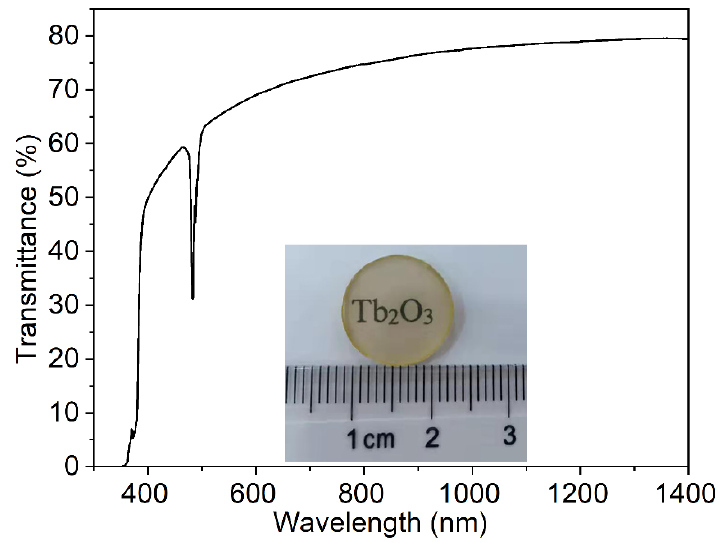
Figure 5. Photograph and in-line transmission curve of the synthetic Tb 2 O 3 ceramics (thickness = 1.0 mm).